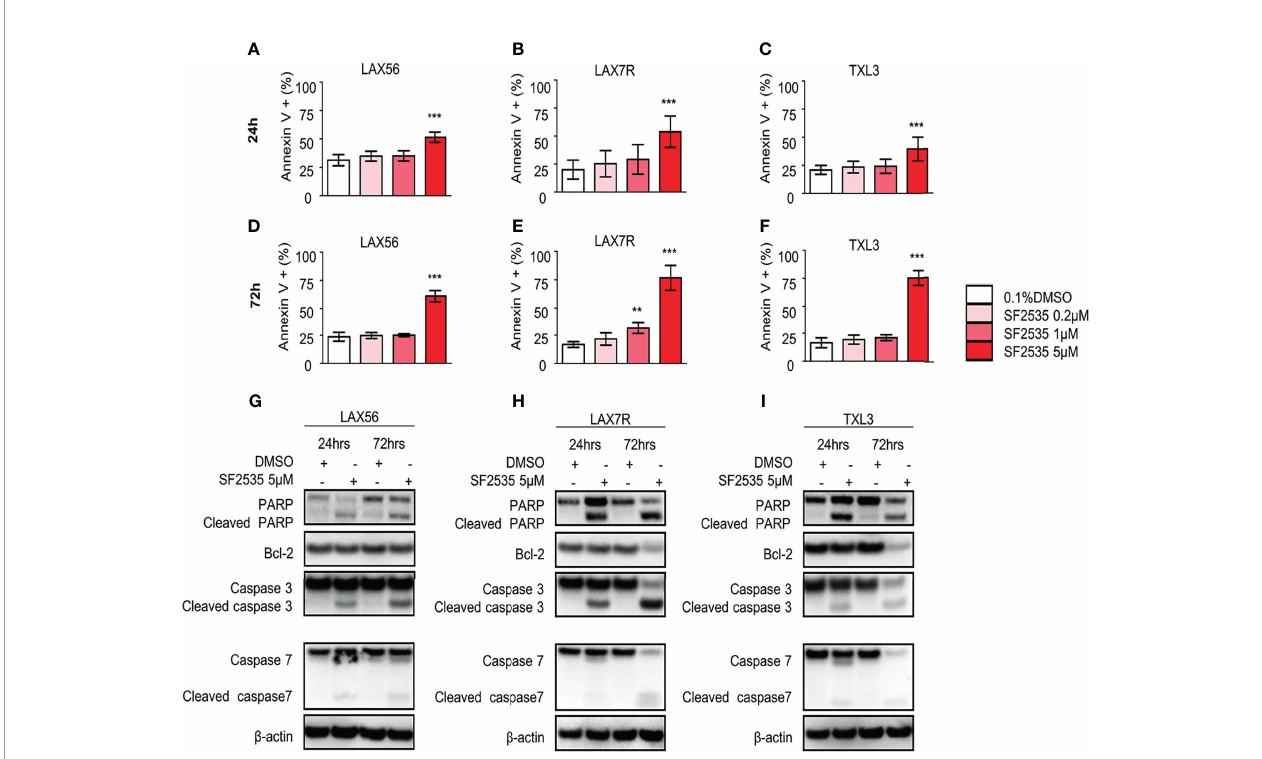
FIGURE 2 | SF2535 induces apoptotic effects in B-ALL cells. LAX56, LAX7R and TXL3 B-ALL cells were cultured in presence of 0.1% DMSO (white bars) or SF2535 (0.2 m M, 1 m M, or 5 m M) (in red bars) for 24 (A – C) and 72 hours (D – F) and apoptosis was assessed by percent of Annexin V + cells by fl ow cytometry. Data are pooled from four independent experiments performed in triplicates. P-values are calculated using one-way ANOVA test and Tukey ’ s multiple comparison test. **P<0.01, ***P<0.001 compared to the DMSO group. LAX56, LAX7R and TXL3 B-ALL cells were cultured in presence of 0.1% or SF2535 5 m M for 24 and 72 hours and proteins were isolated for Western blot analysis (G – I) . b -actin was used as loading control. One of two experiments is